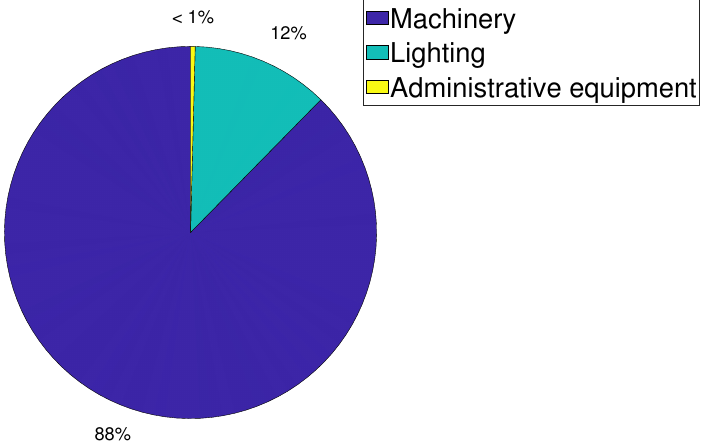
Figure 4. Energy use share in the workshop.